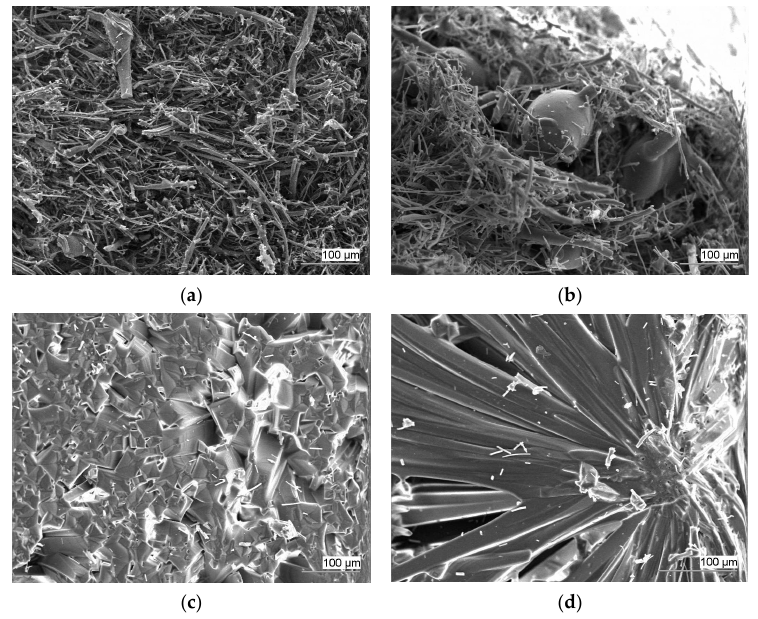
Figure 8. SEM images of the material II after exposure to concentrated solar radiation: ( a ) the first mode, the “cold” side; ( b ) the first mode, the “hot” side; ( c ) the fusion mode; ( d ) the fusion mode,